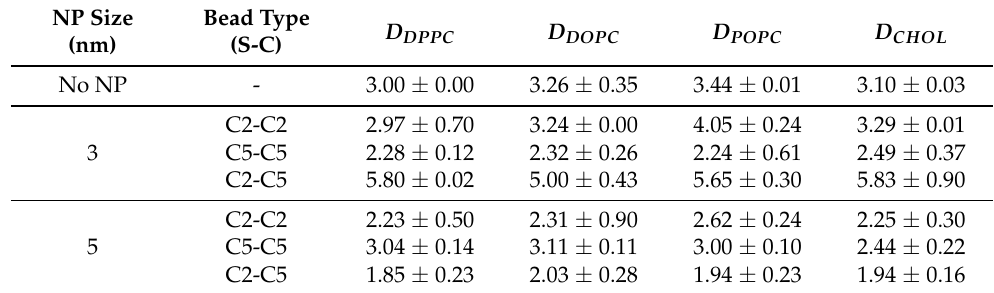
Table 1. Diffusion coefficients (in units of 10 − 7 cm 2 s − 1 ) for all lipid types in the pristine membrane and in the presence of Ag CG NP for 3 and 5 nm for different CG bead types. The MSD was computed using the last 2 µ s of the 10 µ s production run. The standard error for all average values is also